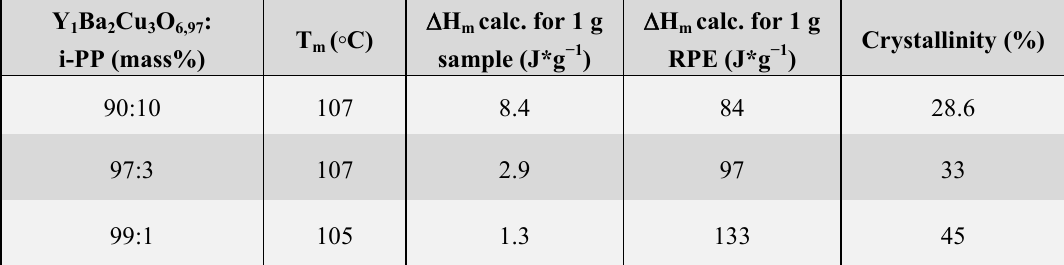
) of nanocomposites depending on m